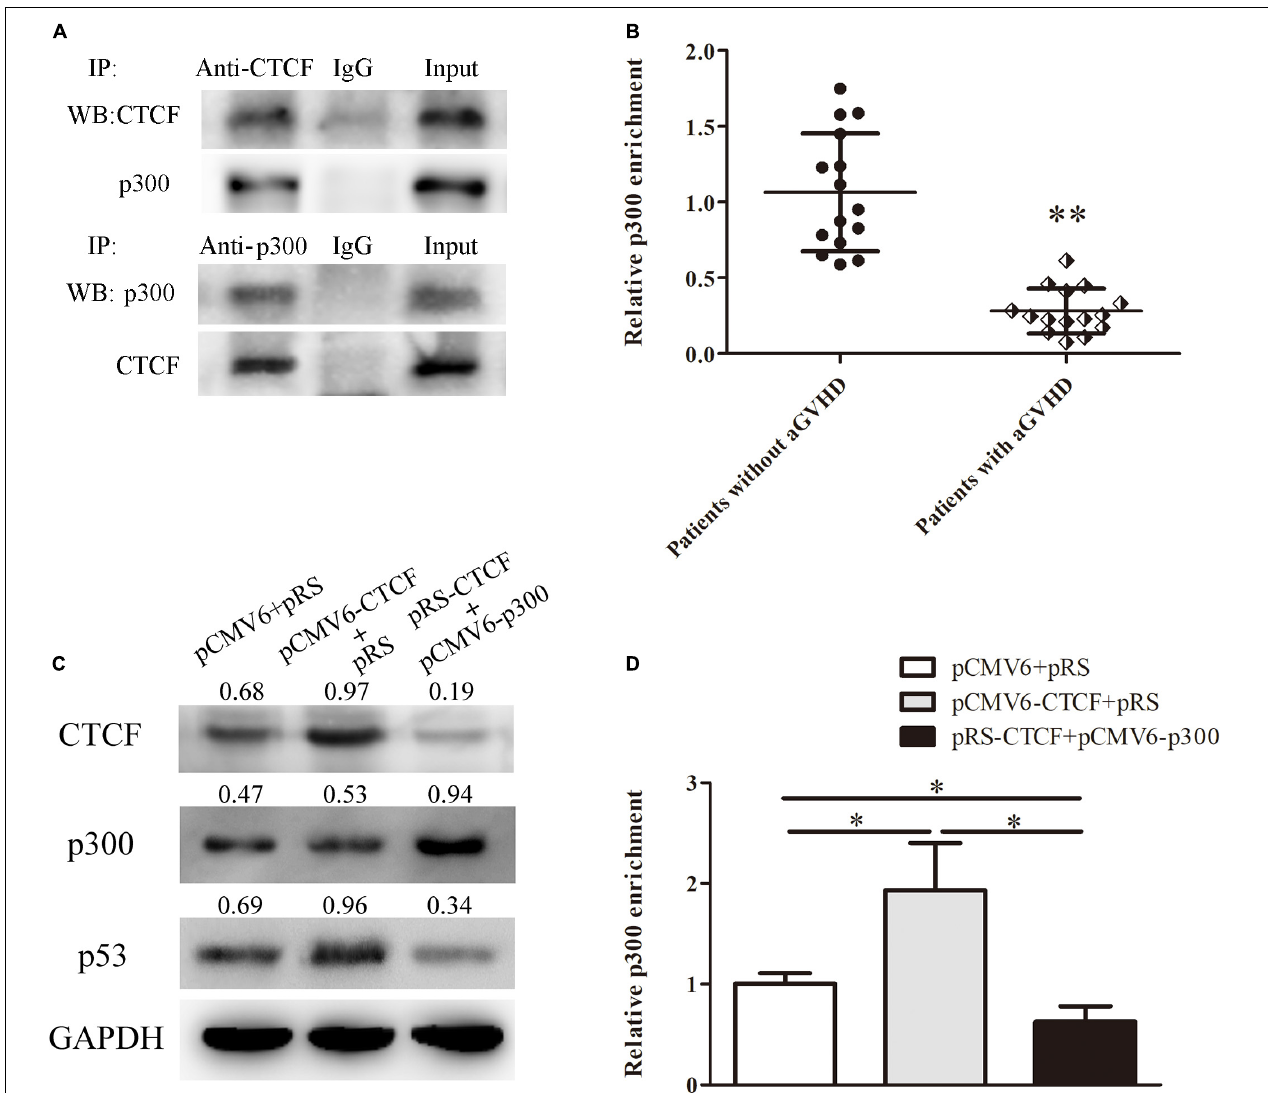
FIGURE 4 | CTCF recruits p300 for interaction with the p53 promoter. (A) Co-immunoprecipitation with anti-CTCF (upper panel) or anti-p300 (lower panel) antibodies in Jurkat cells after CTCF and p300 overexpression; detection of the CTCF and p300 complex was performed by Western blotting. (B) ChIP-qPCR analysis of p300 enrichment in the p53 promoter in chromatin fractions extracted from CD4 + T cells from patients with aGVHD ( n = 15) and individuals without aGVHD ( n = 15). Values are relative to those obtained with input DNA prepared from untreated chromatin. (C) Representative Western blotting results for p53 protein expression in CD4 + T cells after CTCF or p300 overexpression and CTCF silencing. Data are mean ± SD from three independent experiments. (D) ChIP-qPCR analysis of p300 enrichment in the p53 promoter in chromatin fractions extracted from CD4 + T cells after CTCF or p300 overexpression and CTCF knockdown. Values are relative to those obtained with input DNA prepared from untreated chromatin. Data are mean ± SD from three independent experiments. ∗ P < 0.05, ∗∗ P <